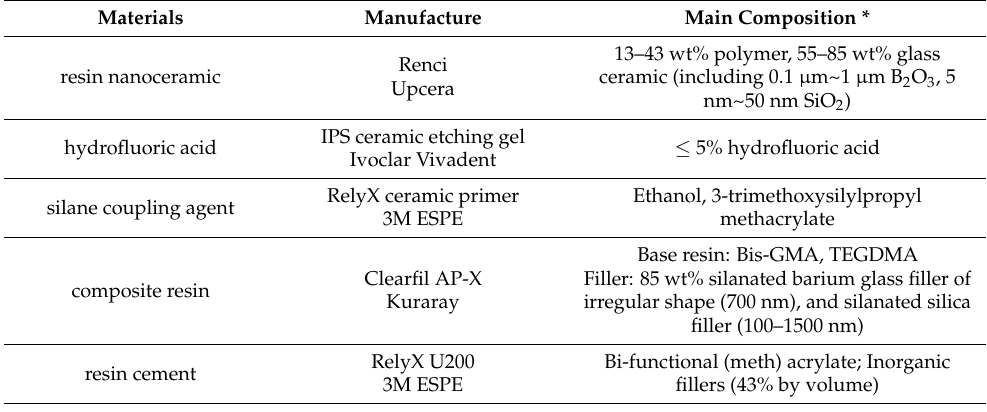
Table 1. Materials used in this study with their manufactures and main